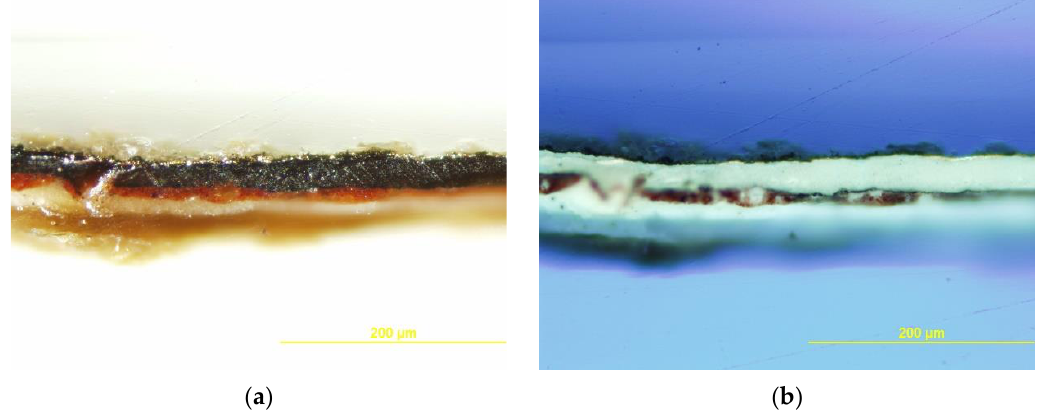
Figure 3. ( a ) Photomicrograph of a polished section of a sample from Qol-e Jalal Cave (QJM006) under normal light and ( b ) in UV light.